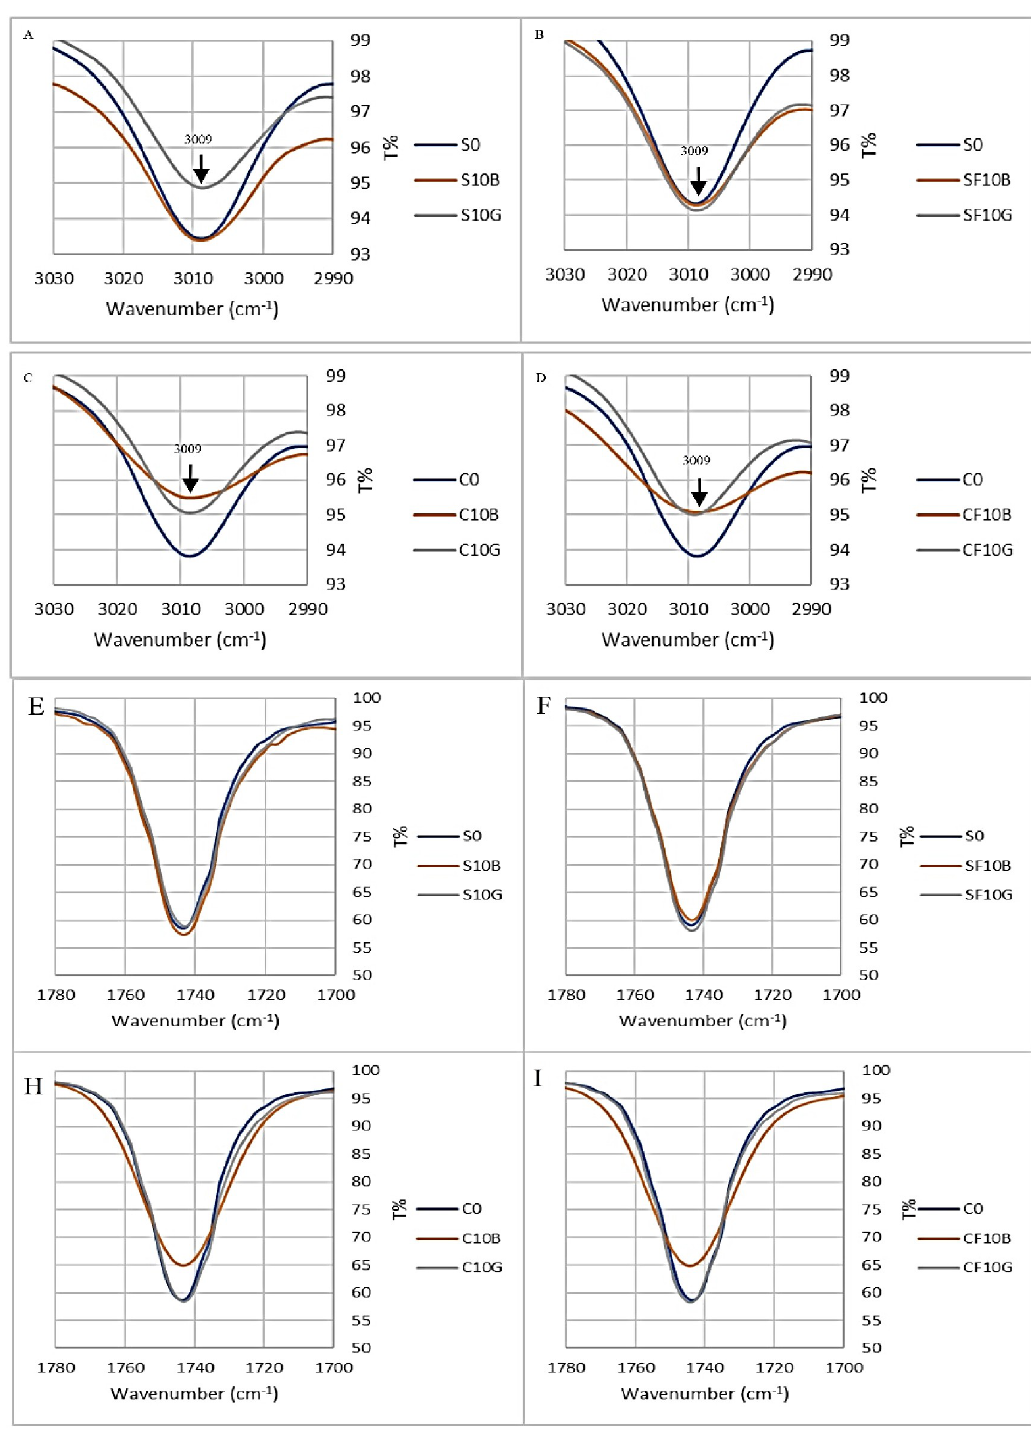
Fig 8. FTIR spectra of the 3006 cm − 1 band (C-H symmetric stretching vibration of the cis double bonds, = CH) of sunflower oil and corn oil samples after treating with black OSAC and green OSAC (A) heated sunflower oil (B) frying sunflower oil (C) heated corn oil (D) frying corn oil, and FTIR spectra of the ~1743 cm –1 (ester carbonyl stretching vibration, C = O) (E) heated sunflower oil (F) frying sunflower oil (H) heated corn oil (I) frying corn oil.